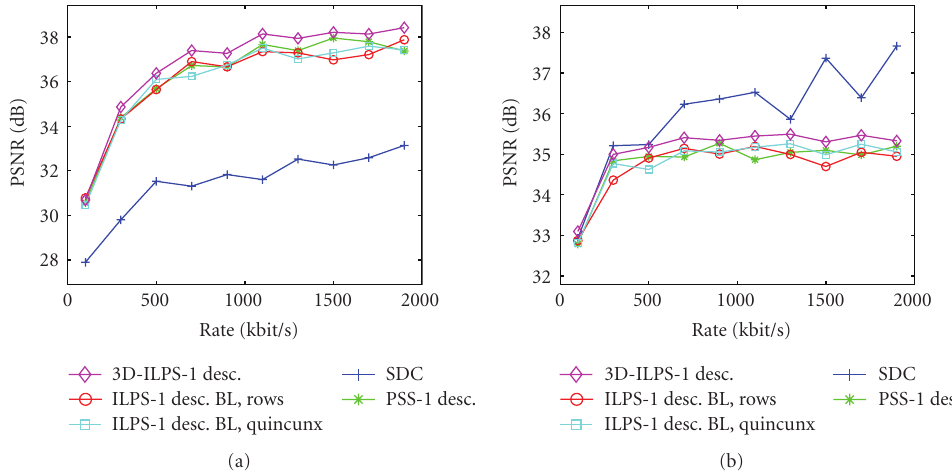
Figure 12: Performance of color view, one subsequence received, 10% packet loss. (a) Breakdance. (b) Ballet.